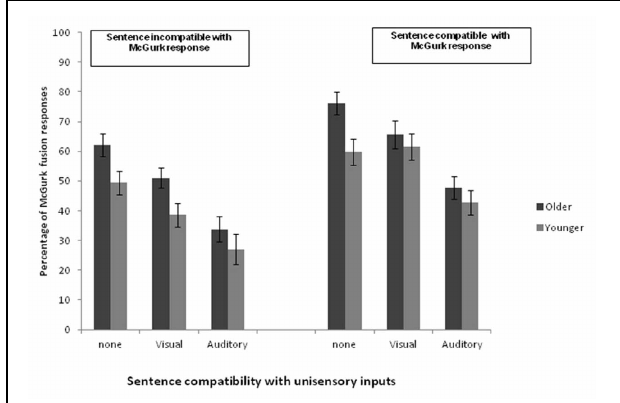
FIGURE 1 | Percentage of “McGurk-fused” responses per condition in Experiment 2. The plots on the left (Sentence incompatible with McGurk response) represent participants’ responses in both age groups when sentence meaning was not compatible with the fused word; on the right (compatible with McGurk response) the plots represent the same conditions when the sentence is compatible with the McGurk fusion